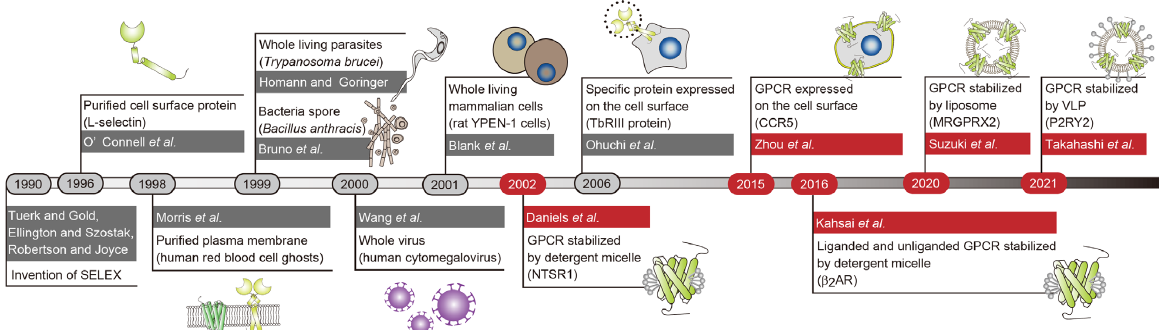
Figure 2. Development of iconic SELEX methods targeting GPCRs and other cell surface proteins. The year in which aptamers targeting GPCRs were reported is shown in red.